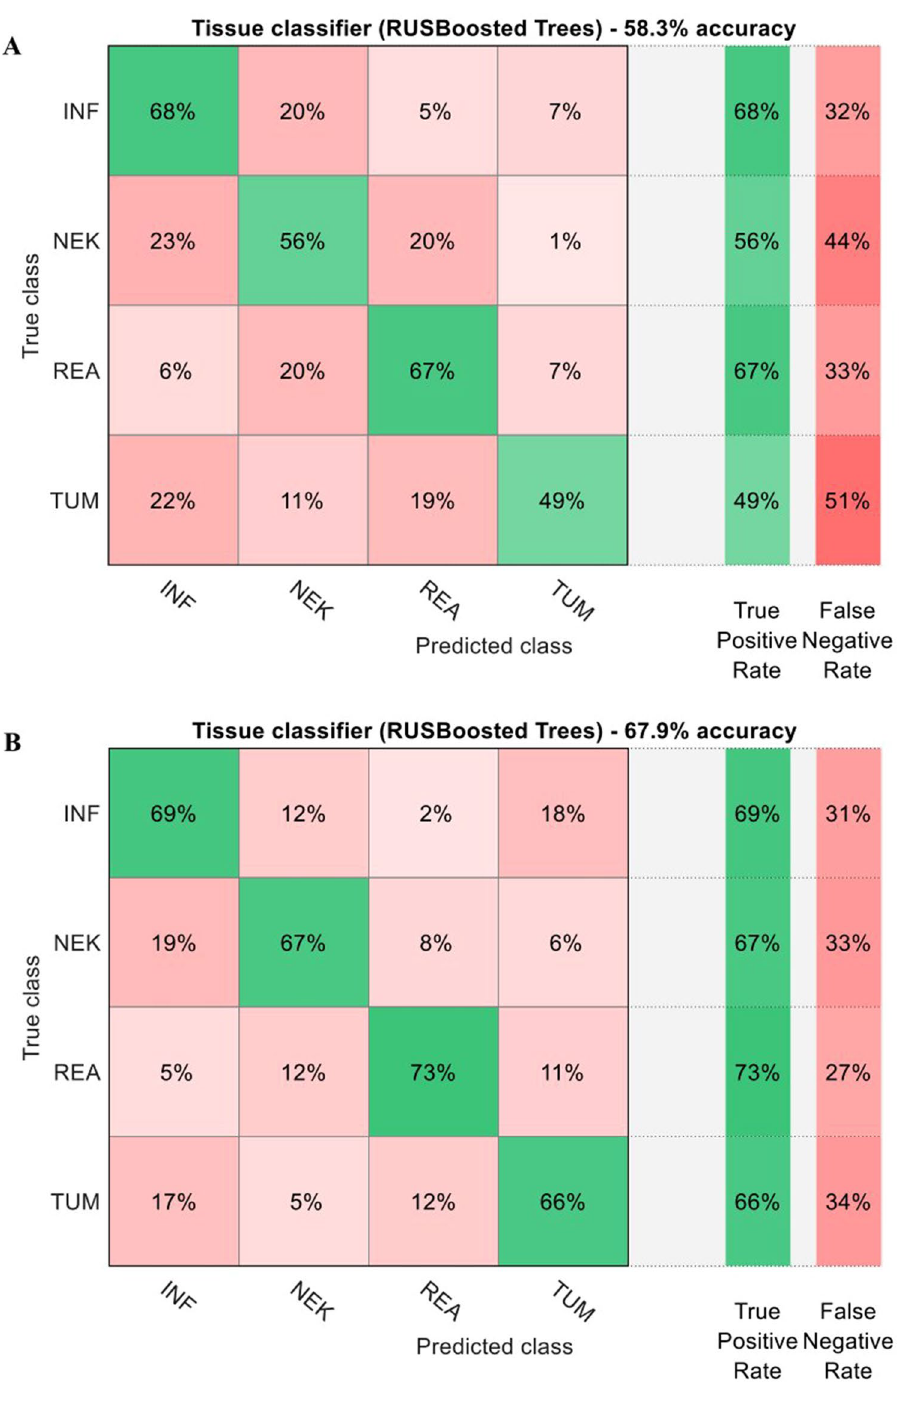
Figure 5. Classification of tumor tissue type based on the fluorescence lifetime of PPIX only ( a ) and NADH/ PPIX combined ( b )—Similarly to the graph shown in Fig. 4, we performed classification depending on the tumor tissue type obtained from histology. While the PPIX only classifier was already able to achieve an accuracy of 58%, the combination with NADH delivers more robust results reaching 68% correct results. Especially samples with distorted energy metabolism like reactive (REA), necrotic (NEK) or compact tumor tissue (TUM) benefit from the additional information delivered by the NADH fluorescence